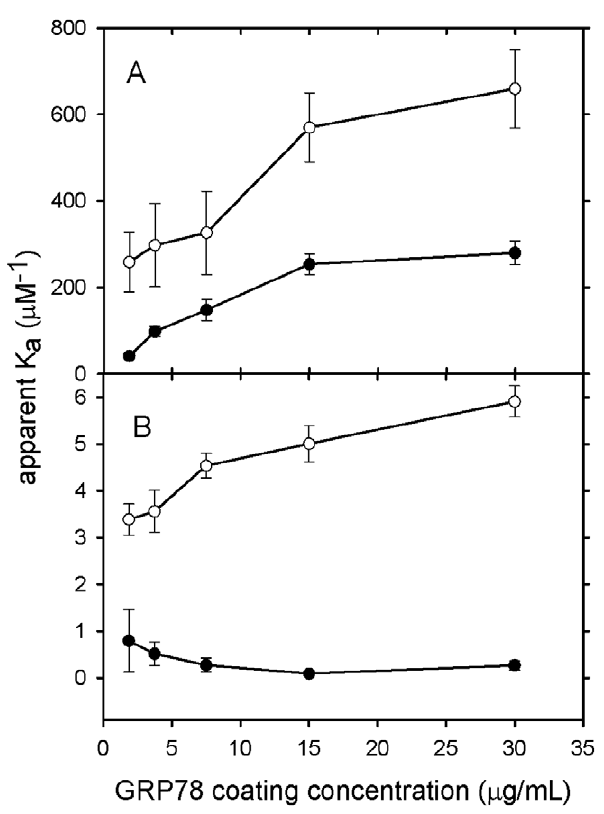
Figure 8. Apparent binding constants (K a ) obtained from the analysis of the data in Figure 7 obtained as a function of GRP78 loading concentration. A. Binding constants for PAT-SM6 (closed circles) and PAT-SM6-hex (open circles). B. Binding constants for PAT-SM6 IgG (closed circles) and anti-GRP78 (open circles).